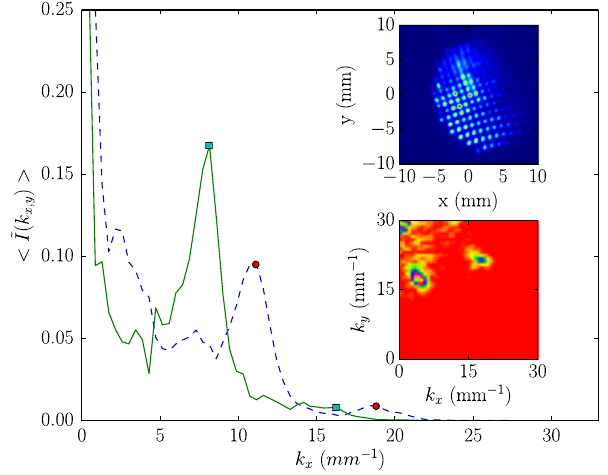
12. TBF as a function of horizontal k x (solid trace) and vertical k y (dashed trace) spatial frequency. The pattern rotation =k angle is computed as tan θ ¼ k x y 1 . This data was extracted 1 from the corresponding beam image (upper inset) and from projections of its 2D FFT image (lower inset).